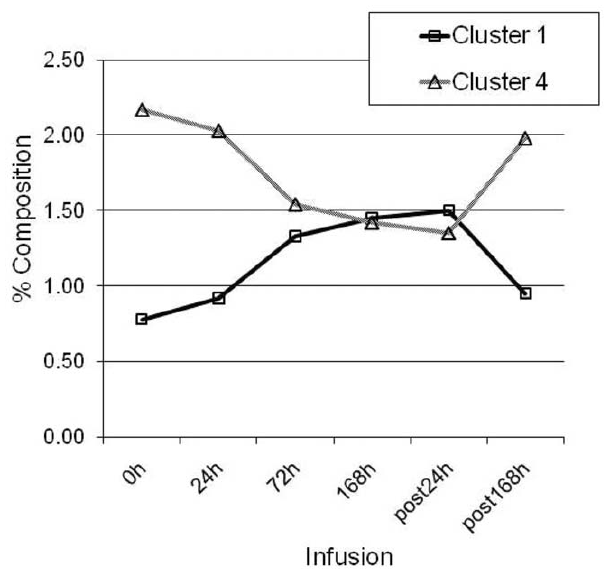
Figure 4. Temporal profiles of the relative abundance (% reads) of Operational Taxonomical Units (OTUs) of Clusters # 1 and 4. Clusters were generated based on Self Organizing Maps (SOM). Percentage composition represents mean normalized percentages of OTUs of 4 samples ( N =4). doi:10.1371/journal.pone.0029392.g004 lowest point at 168 h infusion (Figure 5), which was different from Cluster # 4, where the lowest abundance level was not reached until 24 h post infusion (Figure 4). OTUs annotated to the genus Prevotella were distributed in 3 clusters, Clusters # 2, # 3, and # 4, suggesting its functional divergence. 72 h butyrate infusion induced a sufficient change in the ruminal microbial composition at both genus and OTU levels, which allowed 4 samples at this